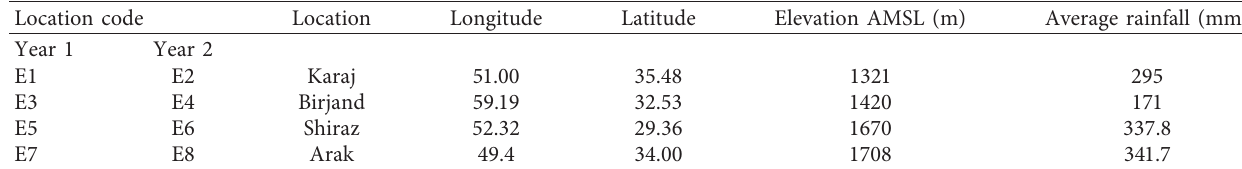
Table 1: Annual rainfall mean, codes, and geographical parameters for different